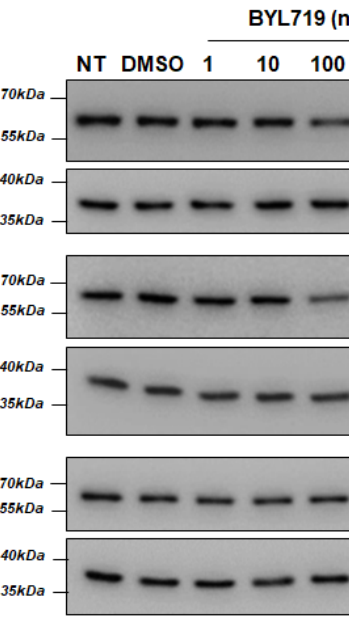
Figure 14. BYL719 inhibits Akt phosphorylation in T11 cells in a dose-dependent manner . T11 cells were treated for 1 h with increasing concentrations of BYL719 and GSK2636771 in complete medium supplemented with 10% FBS. Control cells were left untreated (NT) or treated with DMSO. Phos- phorylation and total levels of Akt were analyzed by Western blotting, with GAPDH used as load- ing control. Signals were visualized using Chemidoc™ MP Imaging System. Graphs show results from densitometry analysis of phosphorylated or total Akt normalized to loading control and ex- pressed as fold change of results from DMSO-treated cells. Data are means ± SEM from the follow- ing numbers of independent experiments: pSer473 Akt, n = 3 (apart from GSK2636771 1 µM, n = 2); pThr308 Akt, n = 3 (apart from NT in BYL719 graph and GSK2636771 1 µM, n = 2); Akt, n = 3 (apart from NT in BYL719 graph and GSK2636771 100 nM and 1 µM, n = 2); ** p < 0.01 vs. DMSO; ## p < 0.01 vs. NT. Inhibition of Akt phosphorylation was also detected in IC1 cells upon 1 h (Supple- mentary Figure S14a) or 24 h (Supplementary Figure S14b) treatment with BYL719. These data indicate that BYL719 inhibits Akt activation in all cSCC cell lines. Together with our previous data, these results indicate that the limited effect of BYL719 on IC1 and T11 cell growth and viability is not due to a generic lack of response to the drug in these cells.